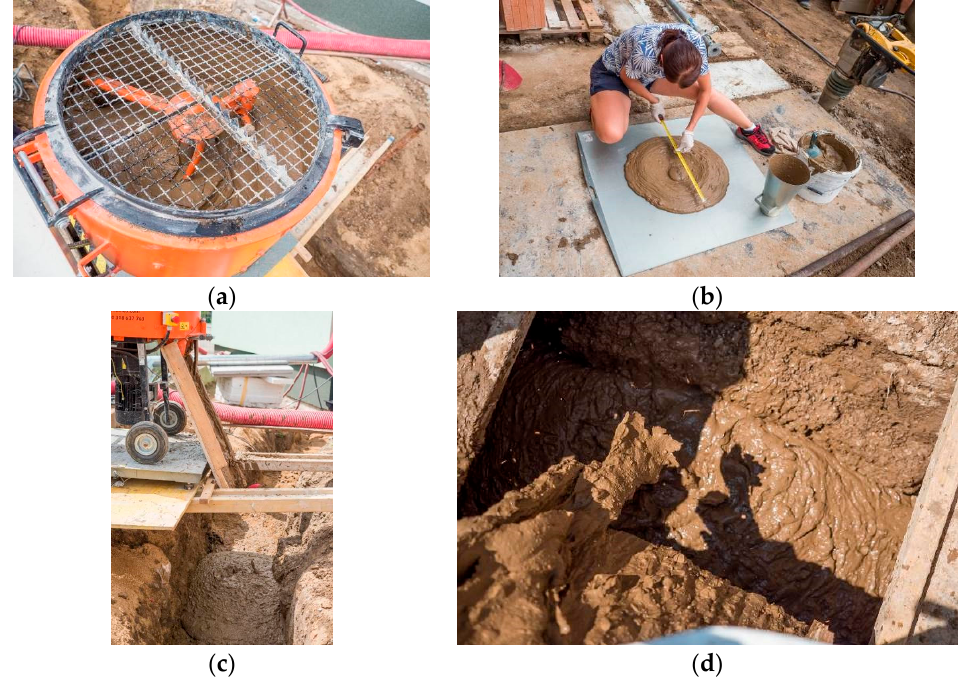
Figure 8. ( a ) Production of self-compacting grout; ( b ) spillage control to achieve a self-compacting effect; ( c ) filling the excavate by self-compacting grout; ( d ) filling the excavate by self-compacting grout.